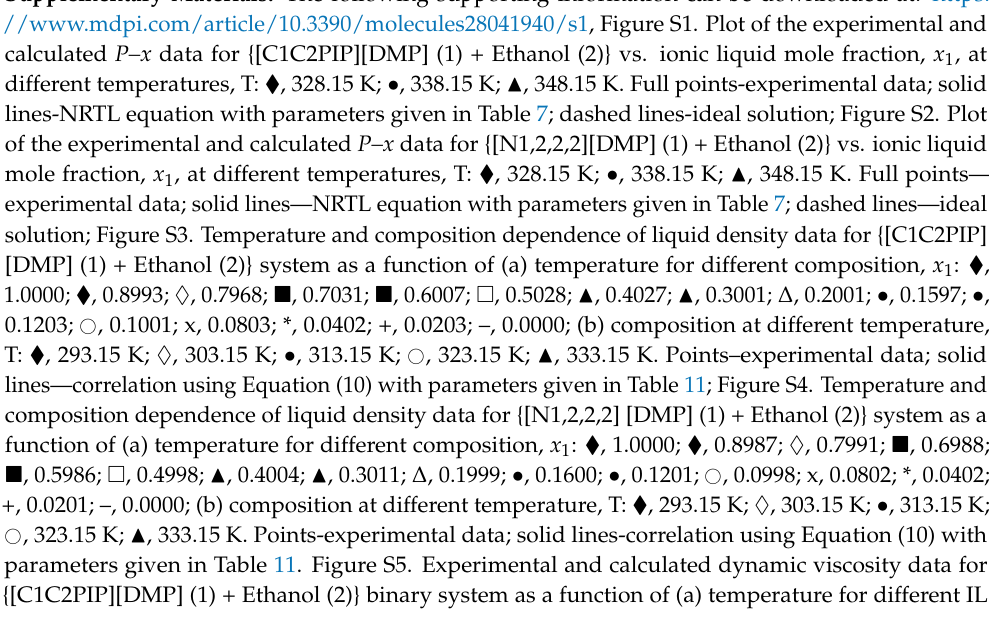
parameters given in Table 11. Figure S5. Experimental and calculated dynamic viscosity data